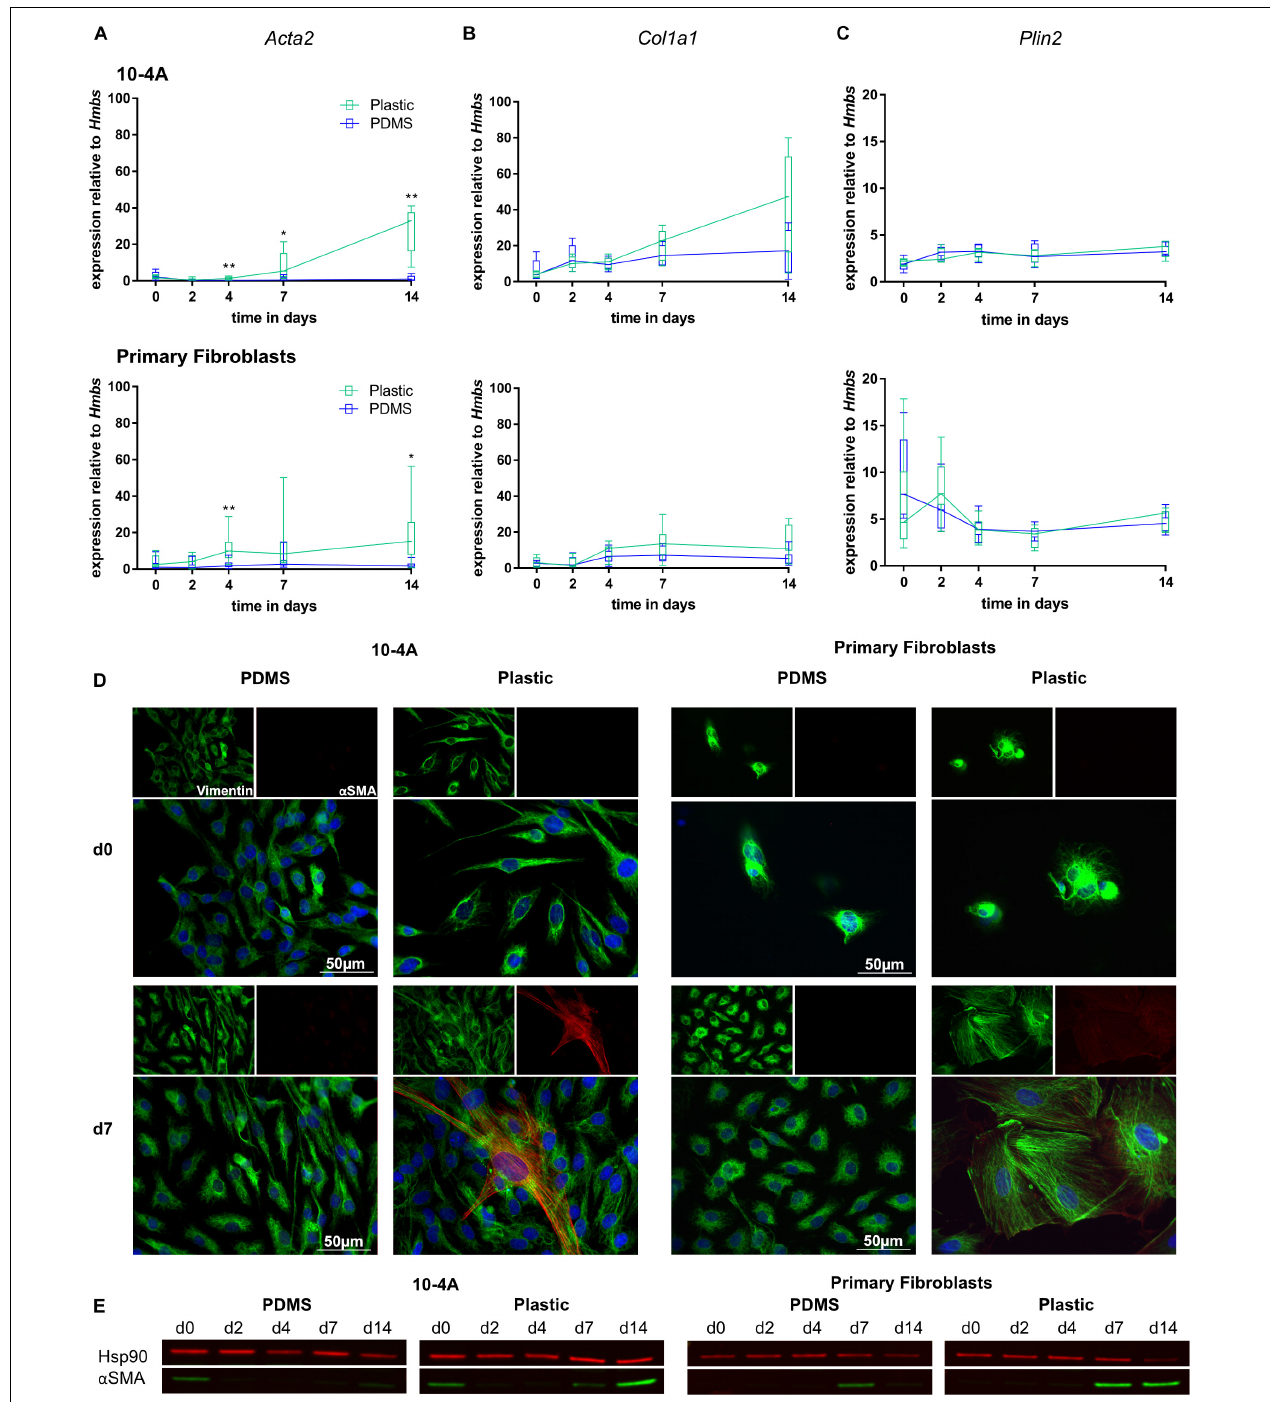
FIGURE 3 | Mechanical stimulation of 10-4A cells and primary fibroblasts. Semi-quantitative RT-PCR analysis of Acta2 (A) , Col1a1 (B) , and Plin2 (C) expression in 10-4A cells (top graph) and primary fibroblasts (bottom graph) maintained on soft PDMS or stiff plastic substrate, respectively. Data are expressed as fold expression of the housekeeping gene hydroxymethylbilane synthase ( Hmbs ). Primary fibroblast data were obtained from seven different animals, 10-4A data from five different passages. Statistical significance for the respective time points was tested with the non-parametric Mann–Whitney- U -Test. Statistical significance is indicated as follows: p -values < 0.05: *, p -values < 0.01: **. Box plots show data as median values, the boxes represent percentiles, the whiskers indicate the minimum/maximum. (D) Immunofluorescence staining of 10-4A cells (left) or primary fibroblasts either seeded on PDMS or plastic directly after adherence (d0) or 7 days post-seeding. Cells were stained for the mesenchymal marker vimentin (green) and the pro-fibrotic protein α SMA (red). Scale bar = 50 µ m. (E) Western Blot for α SMA in 10-4A cells and primary fibroblasts cultured over 14 days on soft (PDMS) and stiff (Plastic) matrices, respectively. HSP90 was used as loading control.